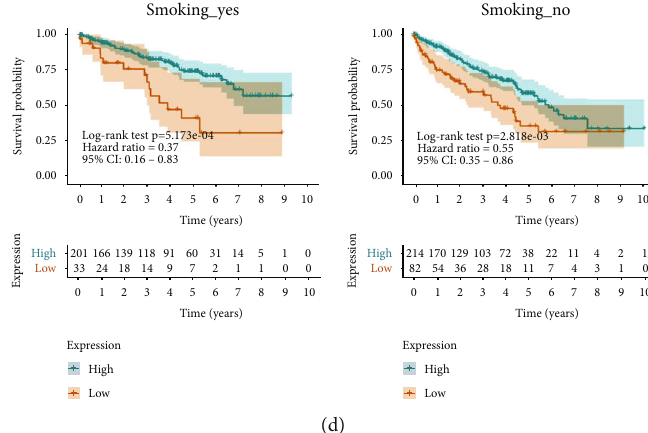
Figure 4: Kaplan-Meier survival analysis of FXYD2 concerning di ff erent clinicopathological factors. (a) Male and female ccRCC patients with low FXYD2 expression both had short-term overall survival. (b) Either patient more or less than 60 years old had short-term overall survival when their FXYD2 expression was low. (c) Either patient with or without pharmaceutical intervention had short-term overall survival when their FXYD2 expression was low. (d) Either smoking or nonsmoking patient had short-term overall survival when their FXYD2 expression was low. Table 2: Relation between FXYD2 expression and immune landscape in ccRCC based on ssGSEA and ESTIMATE in TCGA, GSE40435, GSE57357, and E-MTAB-3267